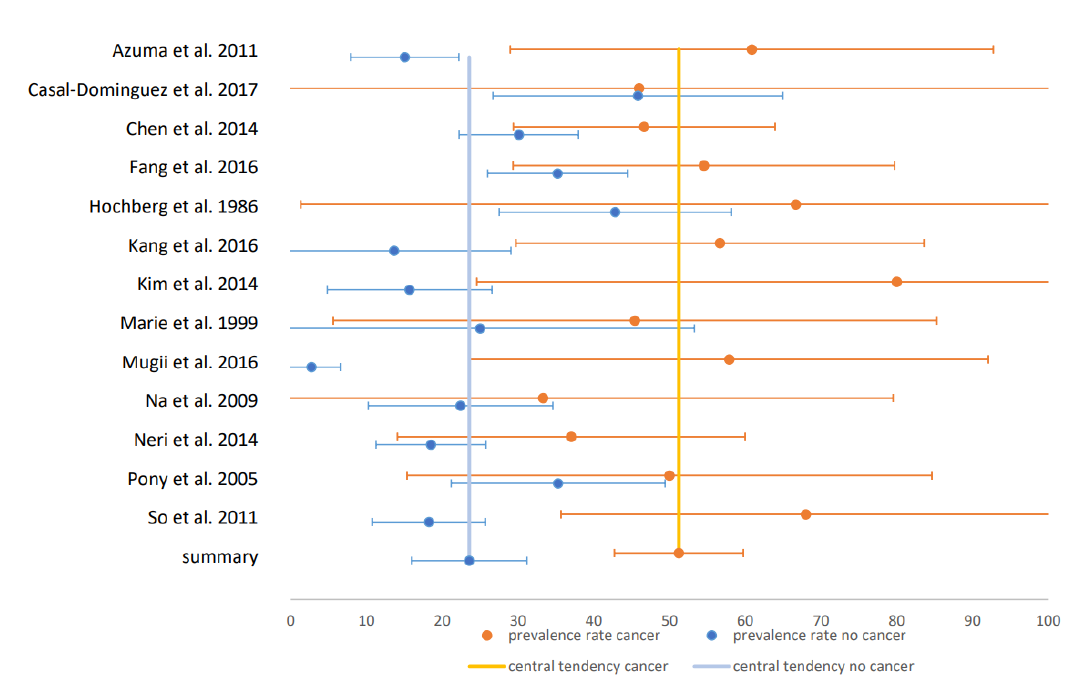
Figure 4. Forest plot for malignancy: Forest plot of the studies comparing prevalence in cancer and non-cancer-associated IIM: x-axis shows the prevalence in %.